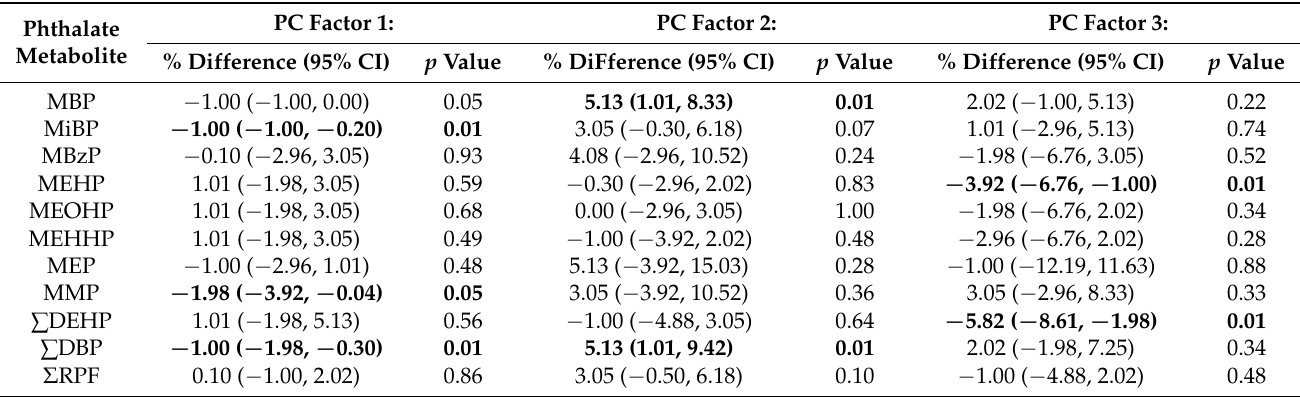
by race. As shown in Table 4, for Whites, greater PC1 was associated with lower levels of MiBP, MMP, and ∑ DBP, and greater PC3 was associated with lower levels of MEHP and ∑ DEHP. Conversely, a greater PC2 consumption pattern was associated with higher levels of MBP and ∑ DBP. As shown in Table 5, both PC1 and PC2 consumption patterns were associated with greater urinary phthalate metabolites among Blacks, whereas a PC3 consumption pattern was not predictive of any urinary phthalate metabolites. PC1 was associated with higher levels of MiBP, MEHP, MEOHP, MEP, and MMP, while greater PC2 was associated with greater MEOHP, MEHHP, and ∑ DEHP, and with larger effects sizes than for PC1. Table 4. Percent difference in specific gravity-adjusted urinary phthalate metabolites associated with principal components (PC) representing food and beverage consumption habits, among White pregnant women (n = 182) a .